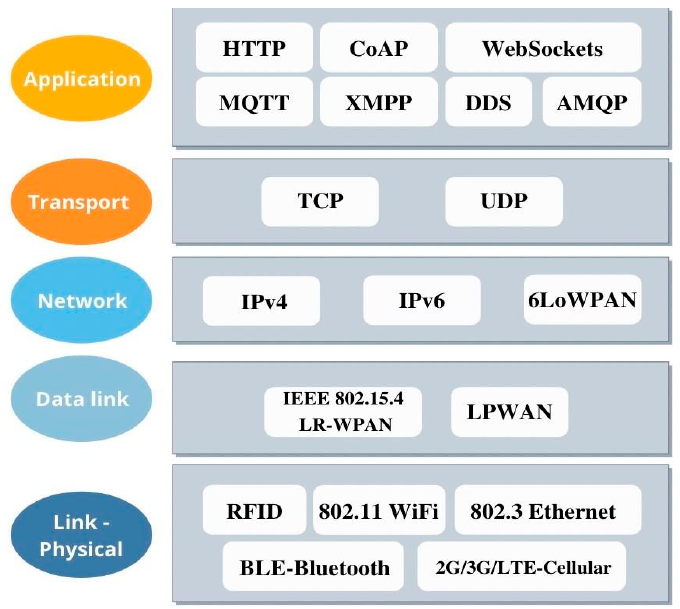
Figure 9. IoT protocols by layer.